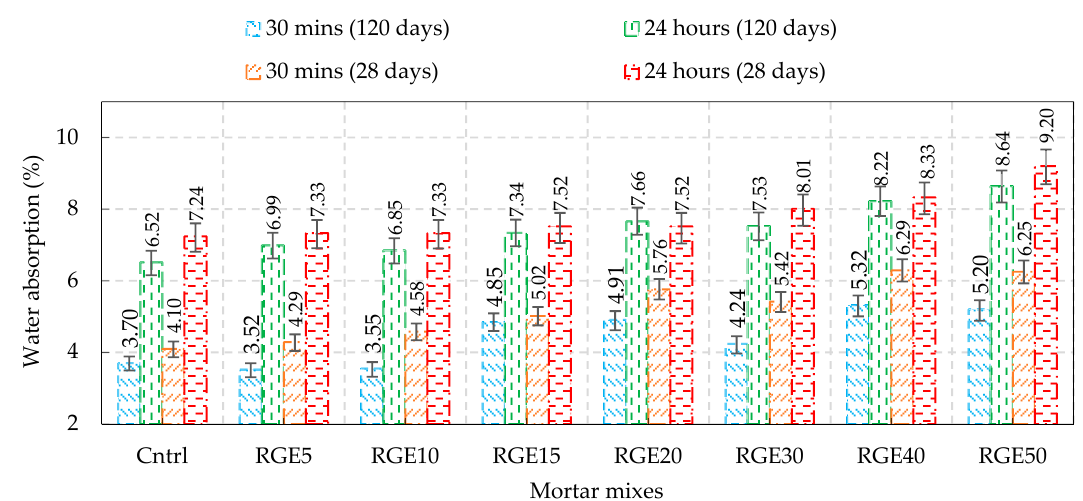
Figure 13. Water absorption at 28 and 120 days (after 30 min and 24 h).